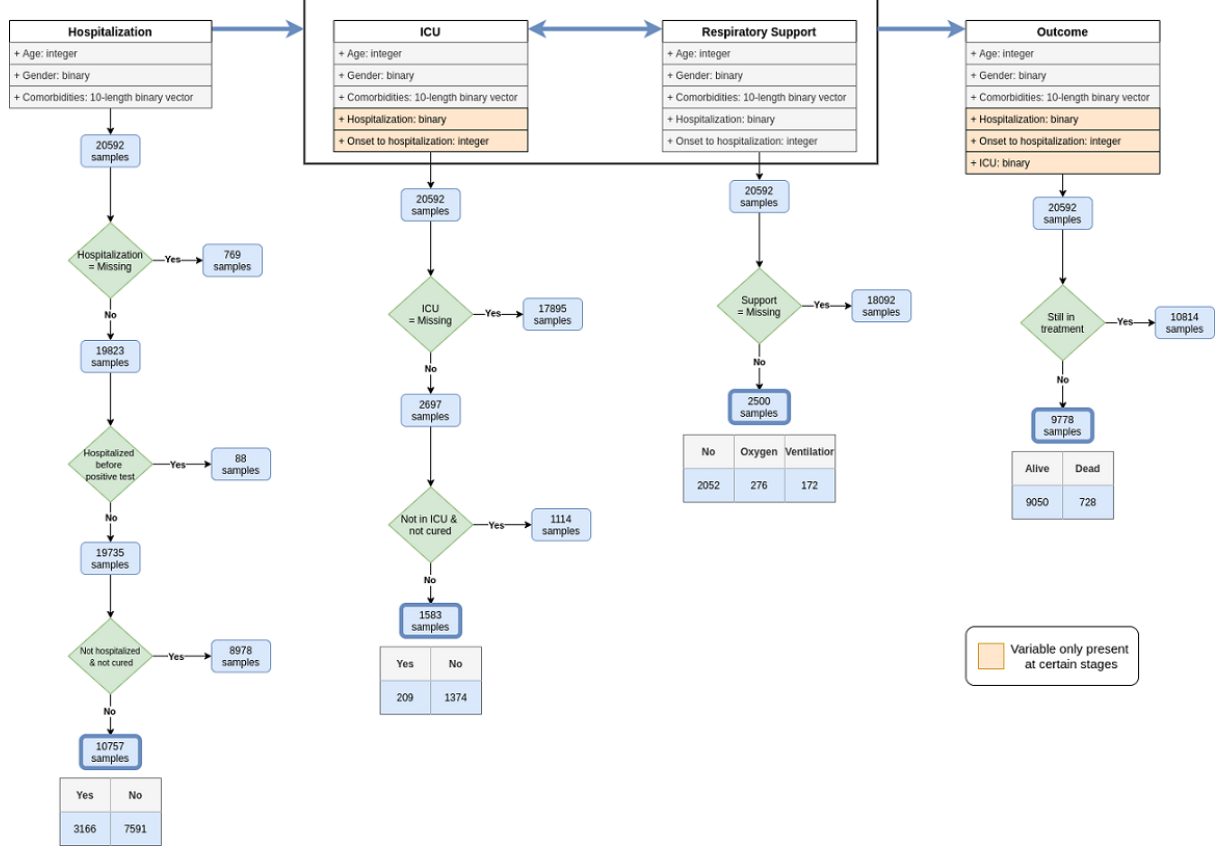
Figure 1. Exclusion and inclusion criteria for composing the outcome-conditional cohorts: hospitalization, respiratory assistance support,